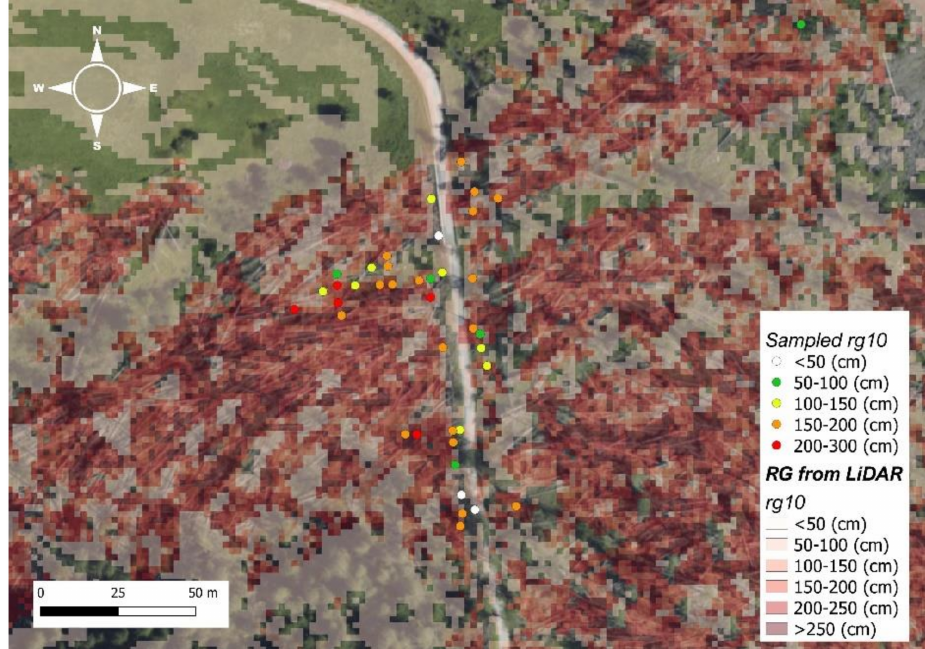
Figure 4. Comparison among roughness ( rg10 ) data extracted by LiDAR and sampled in the field. The map shows the spatialization of RG data obtained through a LiDAR source and of RG data sampled in the